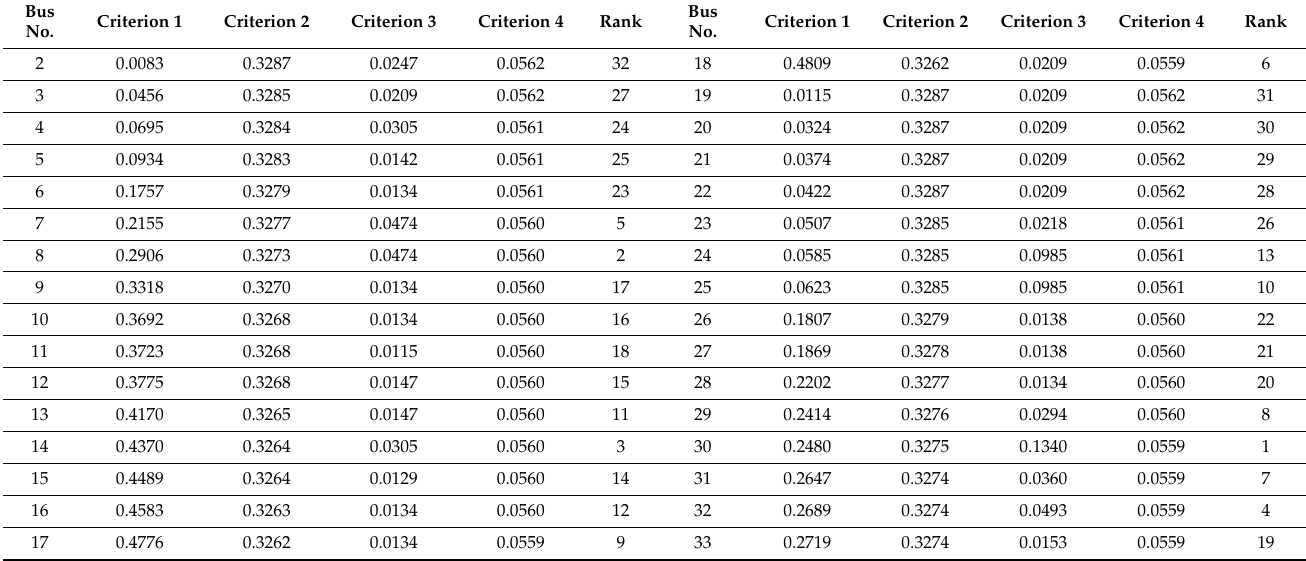
Table 2. Final weight computation and ranks of the distribution network buses.